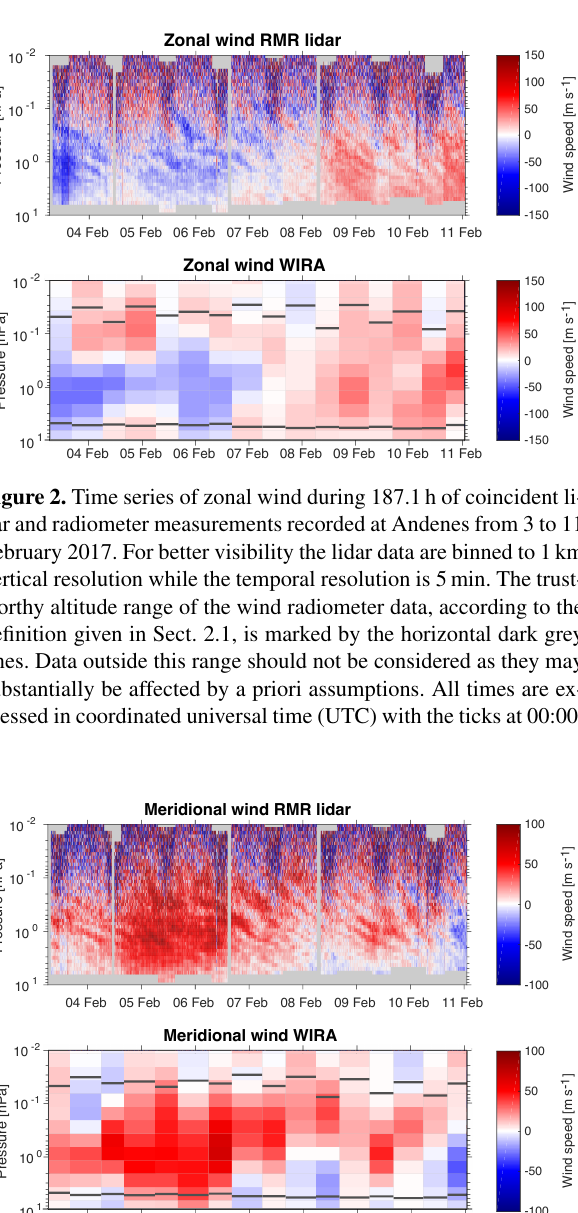
Similar considerations apply to the meridional wind in Fig. 3. Weak northward winds at the beginning of the time series are followed by a strong increase in wind speed be- tween 4 and 7 February in both the radiometer and the lidar observations. The subsequent decrease and reversal to south- ward direction in the stratosphere during 8 February, another increase in northward wind and finally the reversal to sub- stantial southward winds below 0.3 hPa in the night from 10 to 11 February are also recorded by both independent instru-